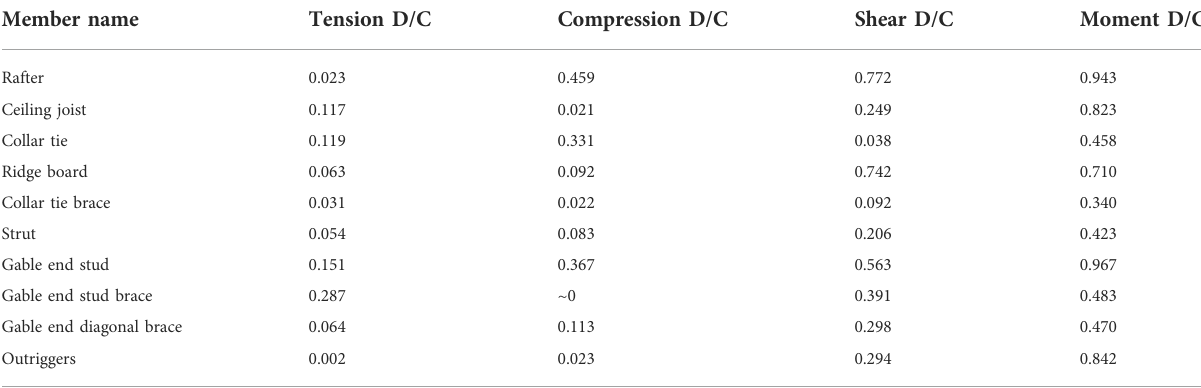
TABLE 8 Final D/C ratios of the